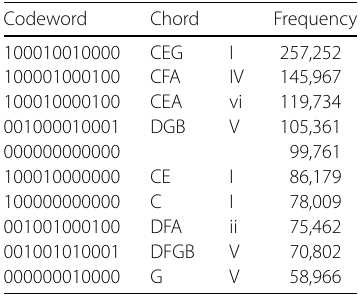
Table 6 Ten most common codewords in the corpus (after transposition), in terms of number of tokens (absolute frequency)